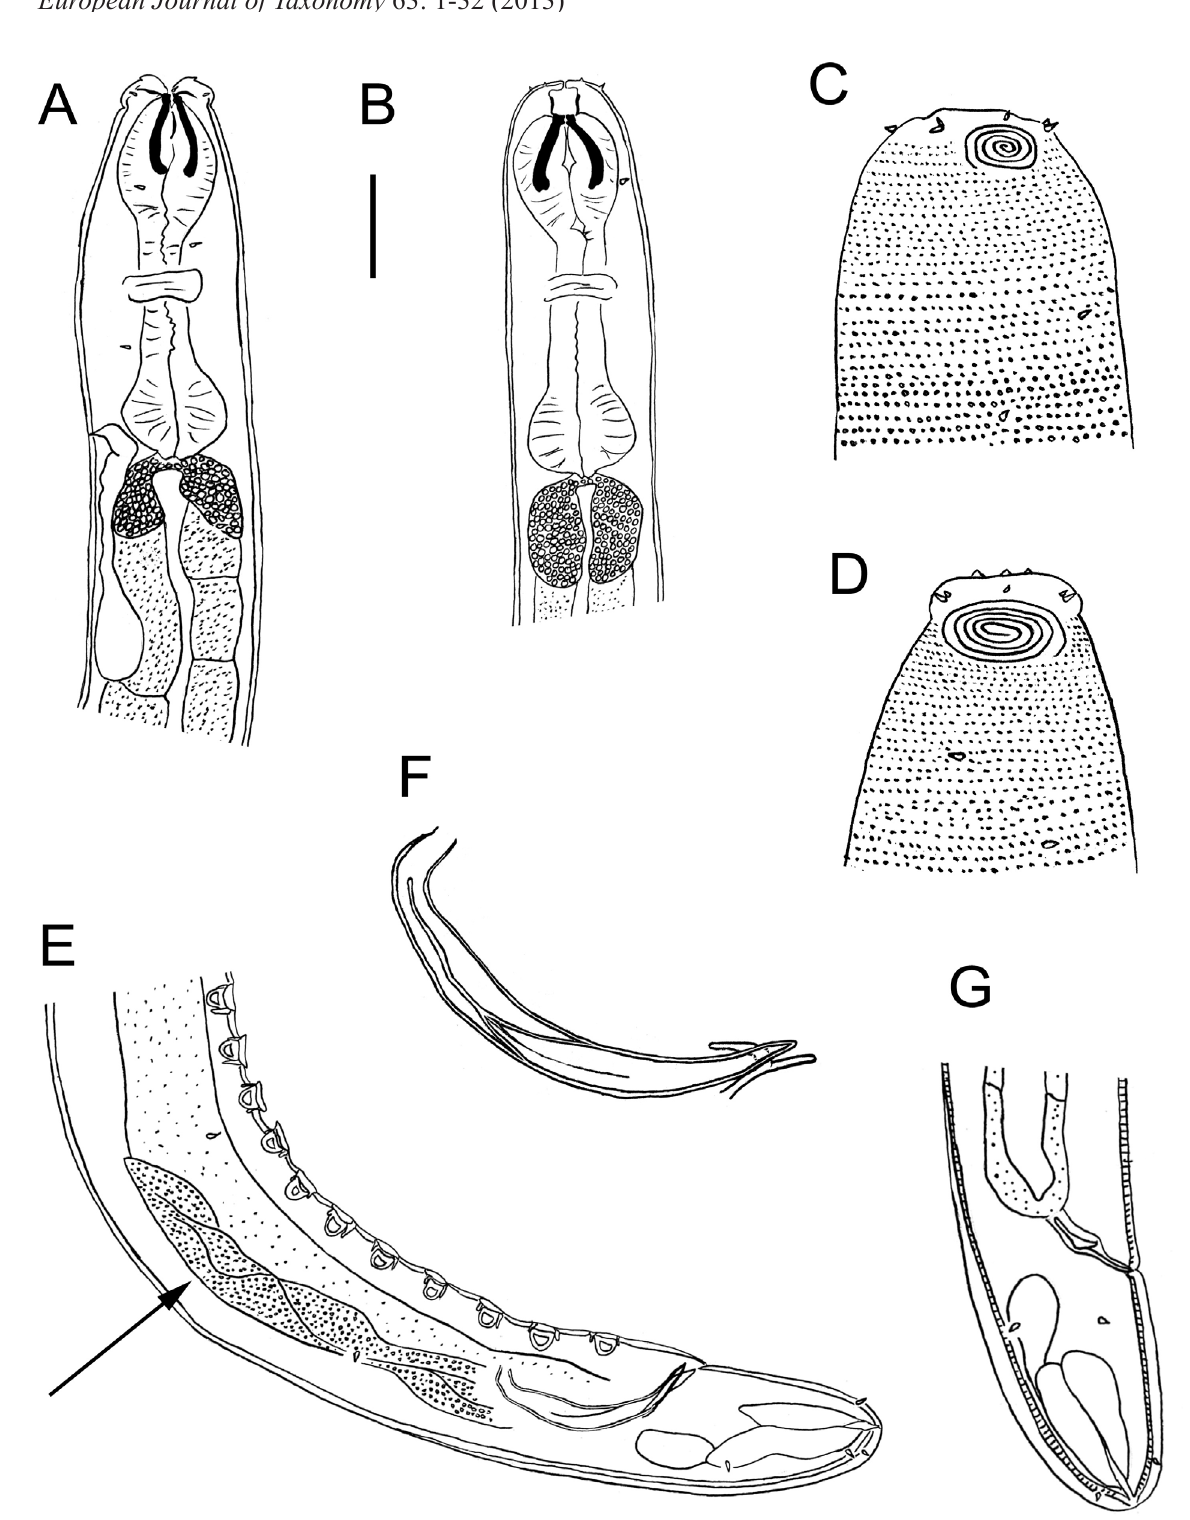
Fig. 4. Pseudocheironchus ingluviosus gen. et sp. nov. A . Lateral view of anterior body region of male. B . Sublateral view of anterior body region of female. C . Surface view of female head. D . Surface view of male head. E . Male posterior body region. F . Spicule and gubernaculum. G . Female posterior body region. Arrow shows location of ejaculatory glands. Scale bar: A-B = 25 µ m; C-D = 15 µ m; E, G = 62 µ m; F = 10